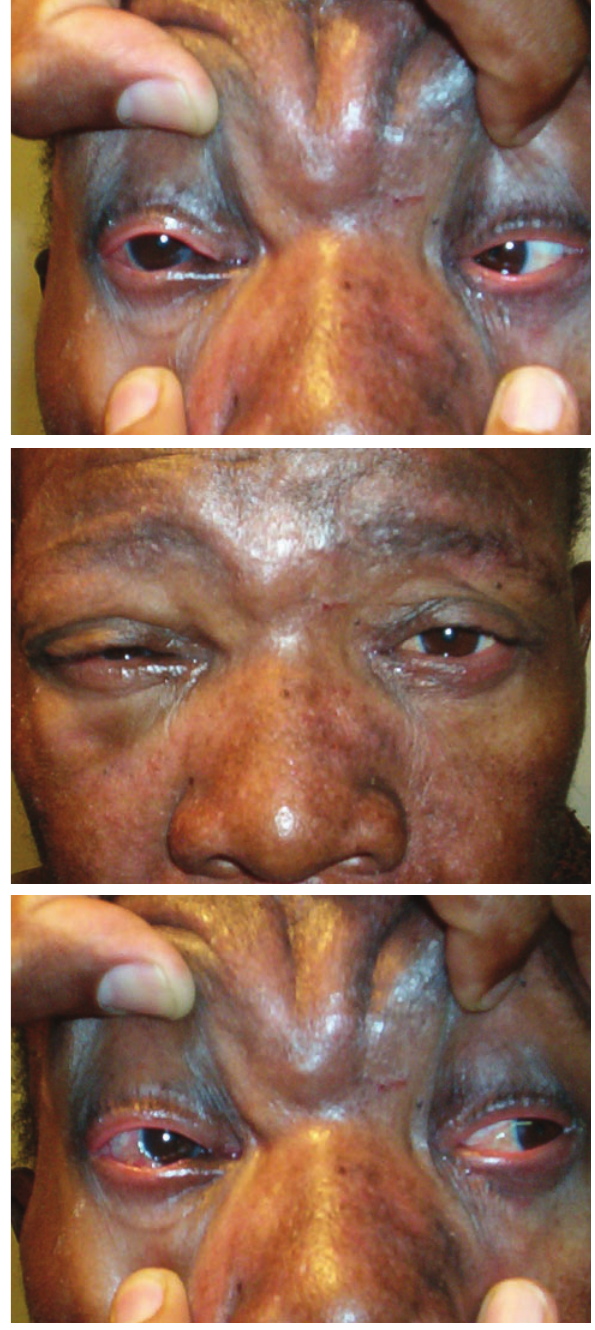
Figure 1. Patient in primary gaze position (middle picture), look- ing to right and to left